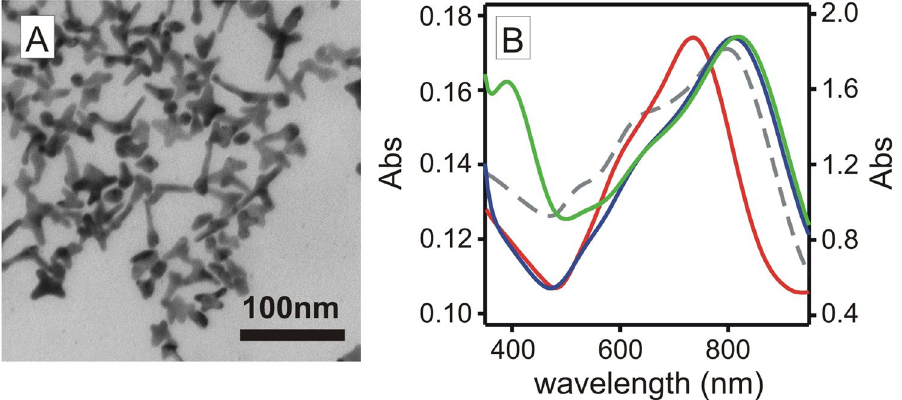
Figure 2. ( A ) TEM image of the GNS used in this work. ( B ) absorption spectra for GNS colloidal solution (grey dashed); Type I slides (red); Type II (blue); Type III